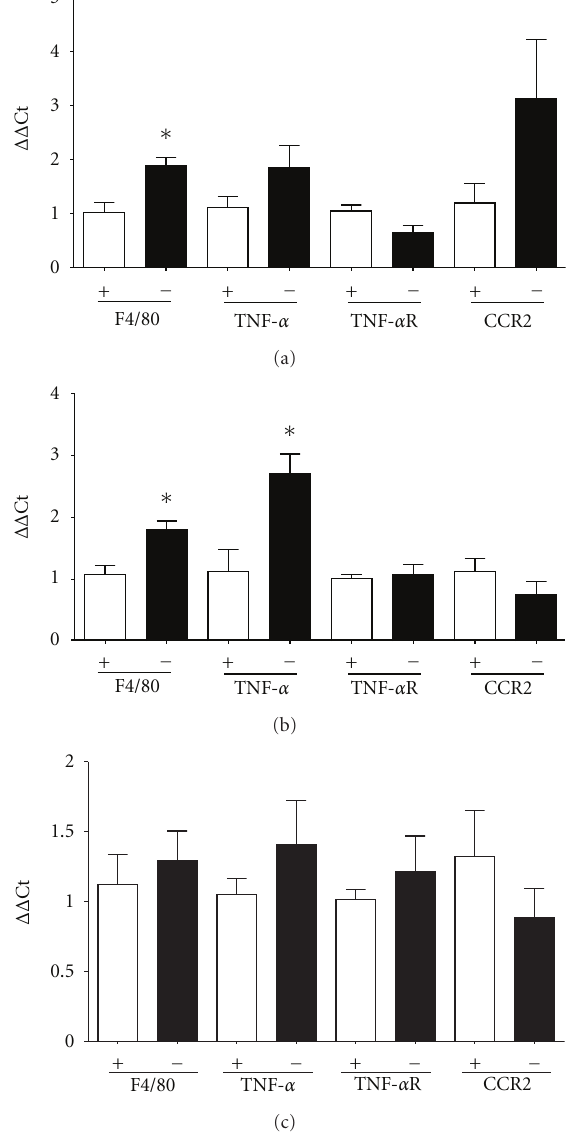
Figure 2: Bone marrow deficiency of ACE2 increases F4/80 and TNF- α mRNA abundance in the stromal vascular fraction (SVF) isolated from visceral adipose tissue of HF-fed C57BL/6 mice. Quantification of mRNA abundance in the SVF isolated from epididymal adipose (EF, a), retroperitoneal adipose (RPF, b), or subcutaneous fat (SubQ, c) of chimeric mice transplanted with Ace2 + /y (depicted on the x -axis as +) or − /y (depicted on the x - axis as − ) bone marrow. Data are mean ± SEM from N = 3–11 mice/donor genotype. ∗ : P < 0 . 05 compared to